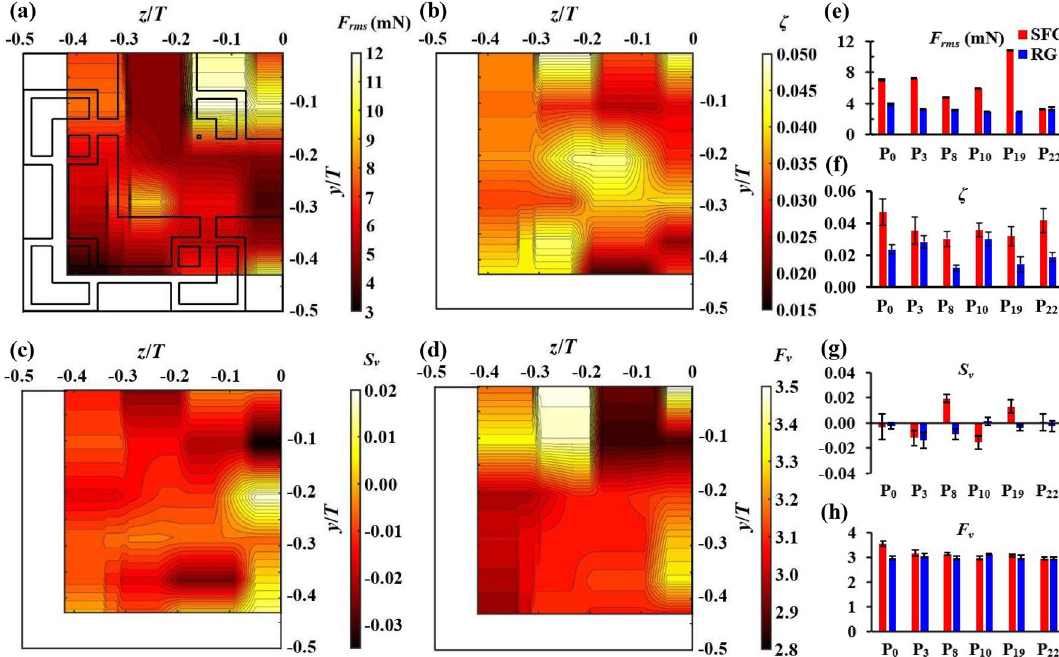
Figure 10. ( a ) F rms , ( b ) ζ , ( c ) S v and ( d ) F v at different lateral positions of SFG and ( e – h ) RG where x / D h =